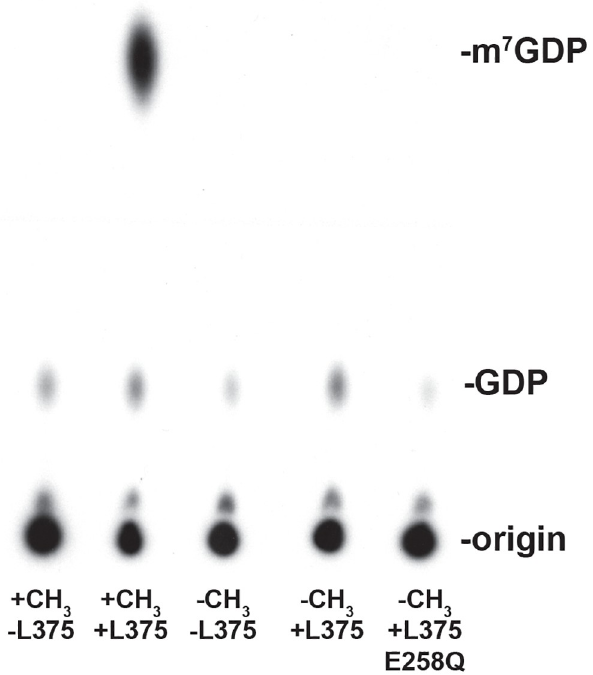
Fig 4. Recombinant L375 specifically cleaves methylated cap structures. (A) The 32 P-cap-labeled actin 309-nt RNA substrate was synthesized either in the presence (+CH 3 ) or absence (-CH 3 ) of the methyl donor S- adenosylmethionine. 0.02 pmol of methylated or unmethylated RNA substrate was incubated with either 50 ng of recombinant wild-type L375 or mutant L375 (E258Q) in mRNA decapping assays as described in Fig 2B.